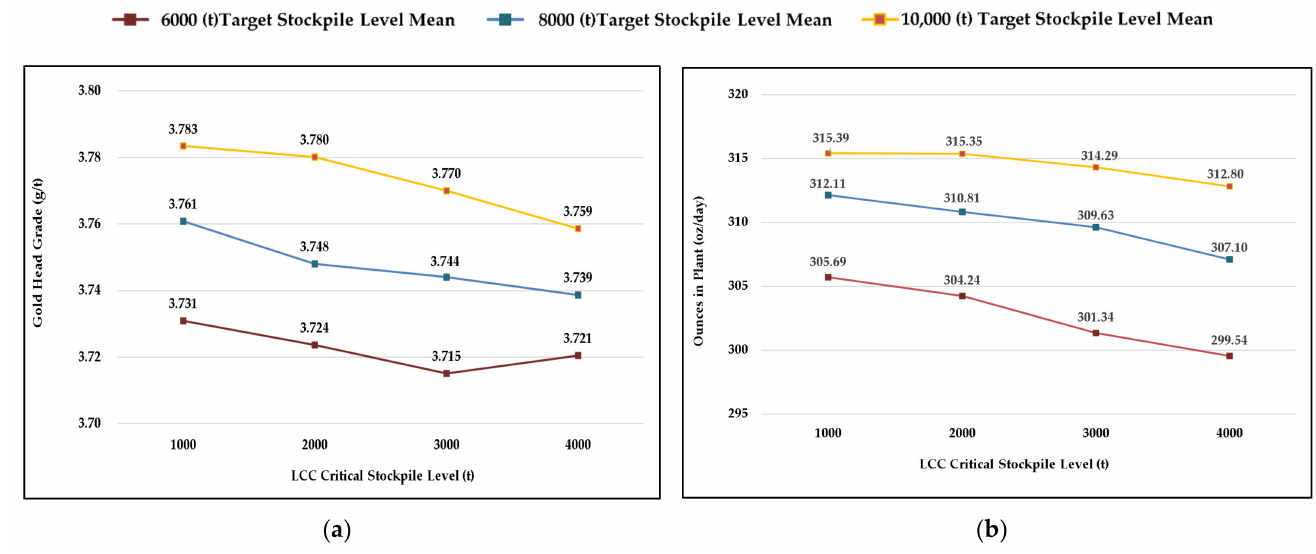
Figure 9. Main simulation statistics as a function of policy parameter target stockpile levels, X = 10,000 t (Yellow line), 8000 t (Blue line), 6000 t (Red line), considering LCC critical stockpile levels, Y = 1000 t, 2000 t, 3000 t. ( a ) Gold head grade averages under different Target Ore Stockpile Levels. ( b ) Gold ounce averages fed into plant under different Target Ore Stockpile